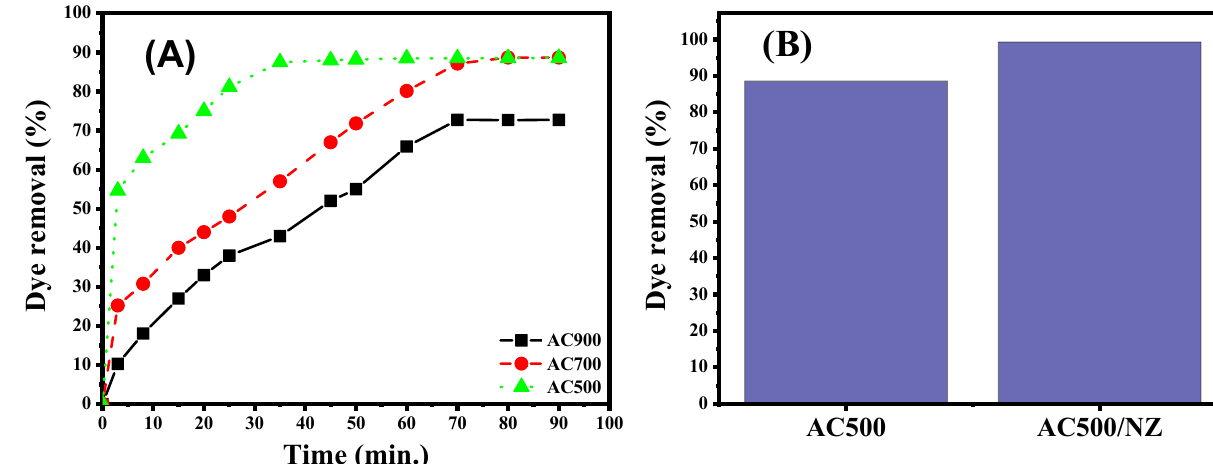
Figure 6. ( A ) The adsorption of 100 mL MB dye solution of concentration 5 mg/L at pH7 using 50 mg AC500, AC700, and AC900 at different times ( B ) The adsorption of 100 mL MB dye solution of concentration 5 mg/L at pH7 using AC500 and AC500/NZ for 45